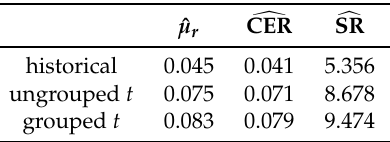
Table 2. Estimated returns, certainty-equivalent returns (CERs) and Sharpe-ratios (SRs) (all in percentage points) of a mean-variance (MV) investor under three investment rules assuming no short-sales: Model-based with grouped and ungrouped t copula and historical. ˆ µ r (cid:100)